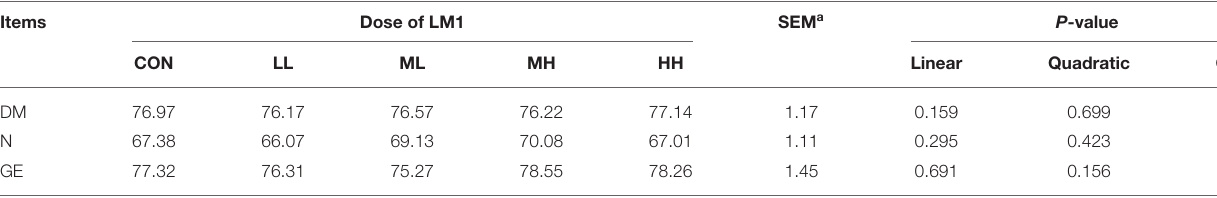
TABLE 3 | Effects of dietary LM1 on ATTD of growing pigs (%).